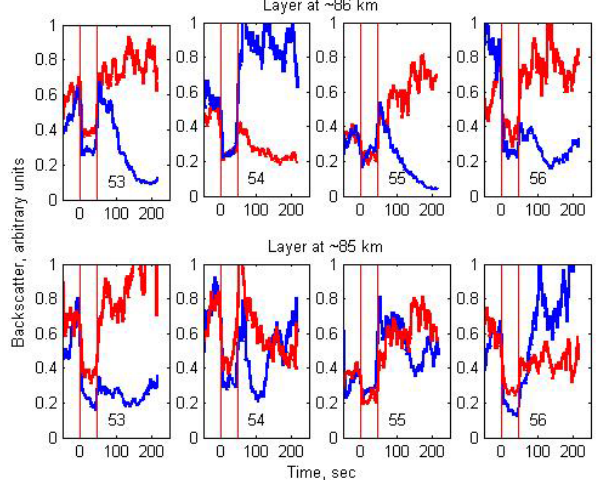
Figure 7. The OCC for four cycles for each of two low single layers at heights ∼ 82 and 81.5km shown on a linear scale from 0 to 1. The OCCs for each cycle have been normalized to coincide at t = 0. VHF is blue; MORRO is red. The heater is on between the two vertical red lines. Heater cycle numbers are given at the bottom of each figure.